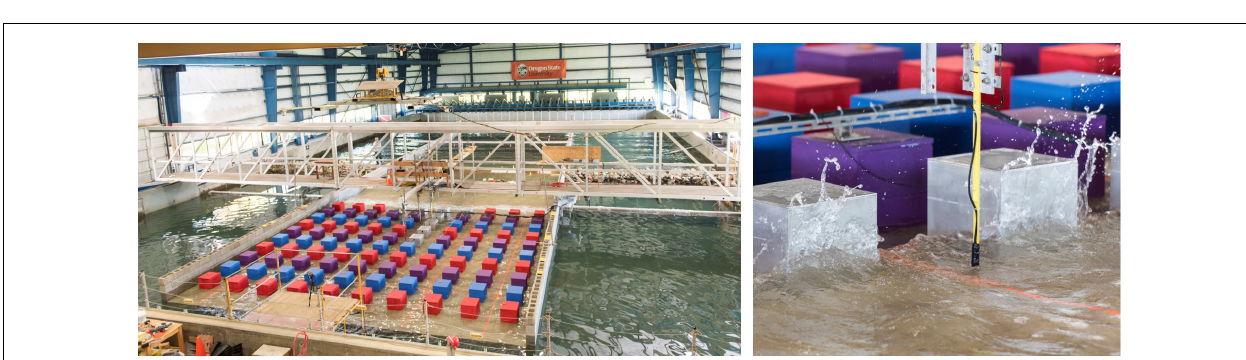
FIGURE 12 | Setup of apparatus in DWB (left) filling of the DWB in preparation for testing with the submarine volcano (right) .